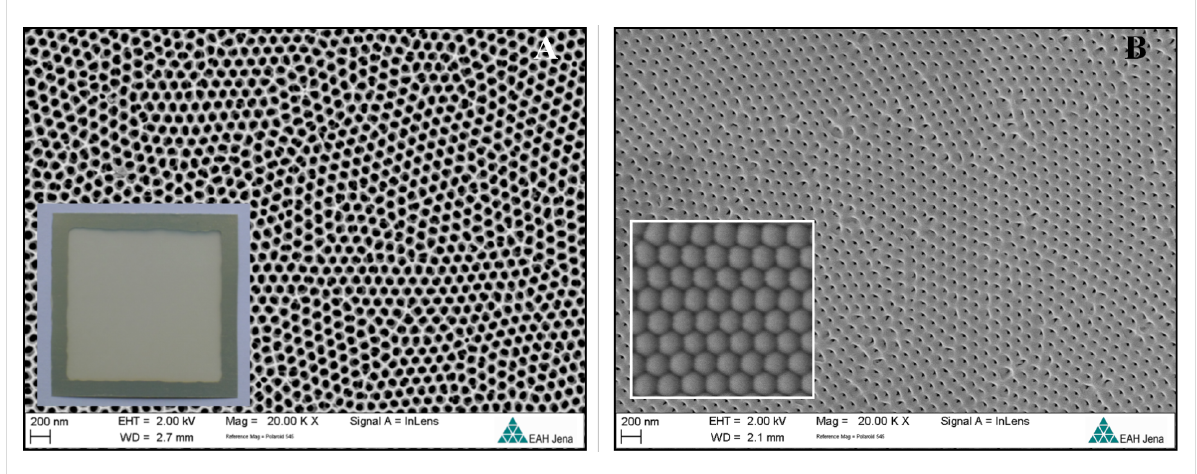
Figure 1: SEM images (after barrier layer etching) of a porous alumina membrane (PAM) fabricated using etch type I (with area 70 × 70 mm). The barrier layer was first opened on the back side using argon ions followed by the usual bilateral acid pickling. (A) top view (outer surface) and (B) top view (inner surface). The insets show optical images of the PAM and the enlarged SEM top view of the back side before barrier layer etching.